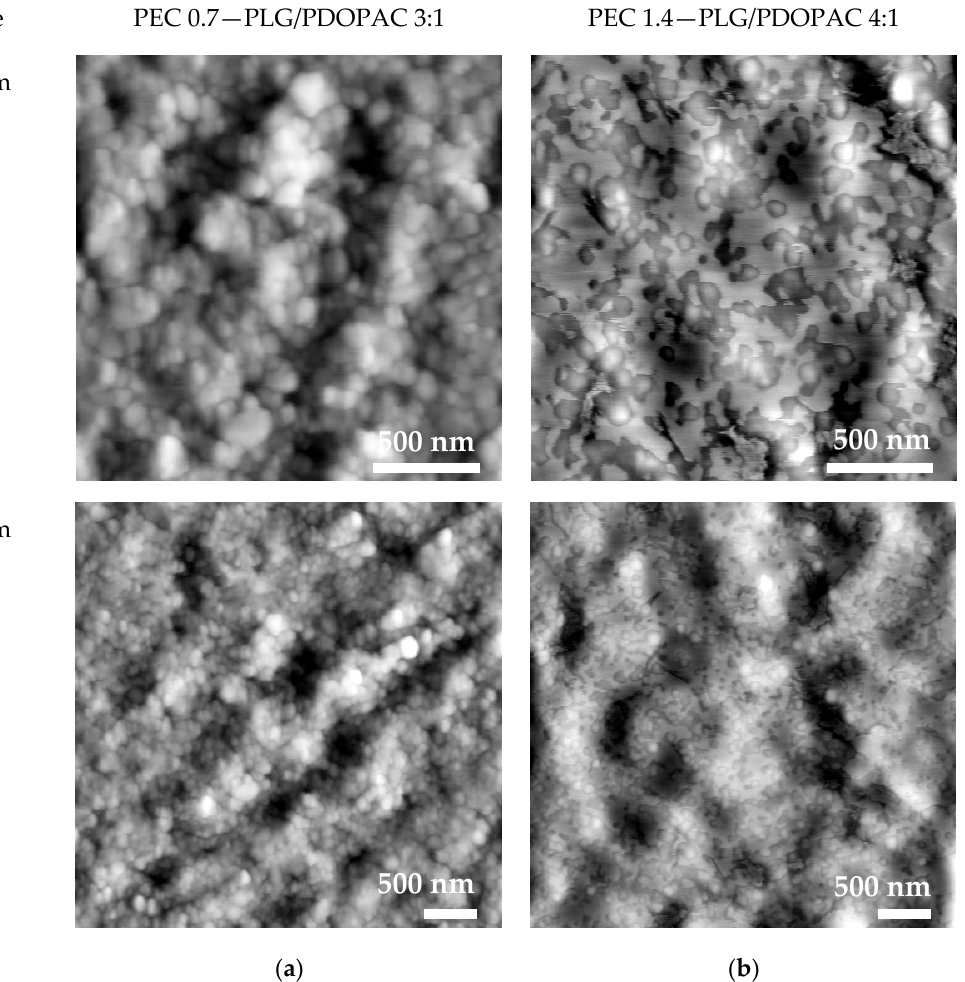
Figure 5. SFM images of PEC coatings from ( a ) cationic and ( b ) anionic ternary PDOPAC/PEC after centrifugation and redispersion under different magnifications.